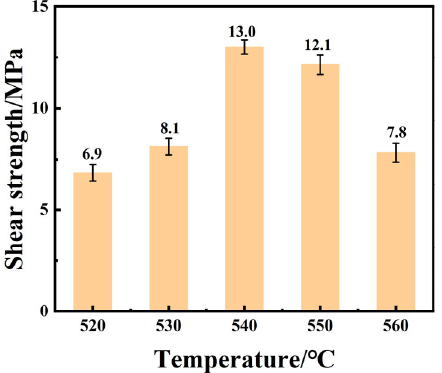
Figure 7. Shear strength of joints at di ff erent sealing temperatures.